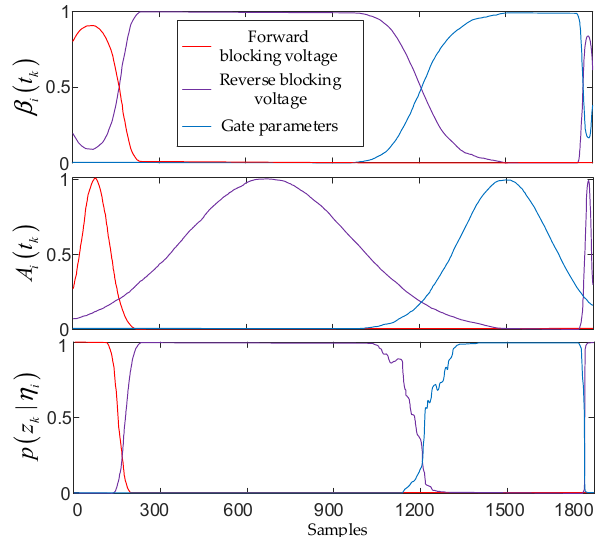
Figure 7. The segmentation result graph of the dataset.